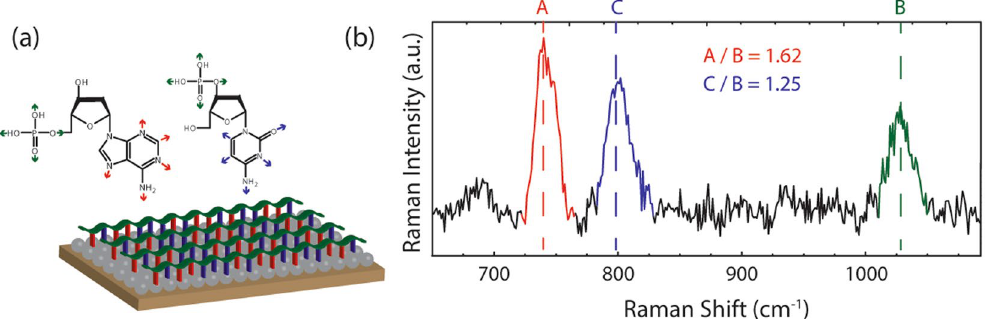
Figure 1. Normalization procedure for DNA composition detection using Raman spectroscopy. ( a ) Illustration of ssDNA functionalized to random silver films on mica showing the ring-breathing-modes of adenine (red), cytosine (blue) and the phosphate backbone mode of DNA (green). ( b ) Proposed normalization procedure in which the intensity of the adenine ring-breathing-mode (508 a.u.), of the cytosine ring-breathing-mode (394 a.u.), and of the backbone mode (314 a.u.) are used to calculate the A/B ratio (1.62) and C/B ratio